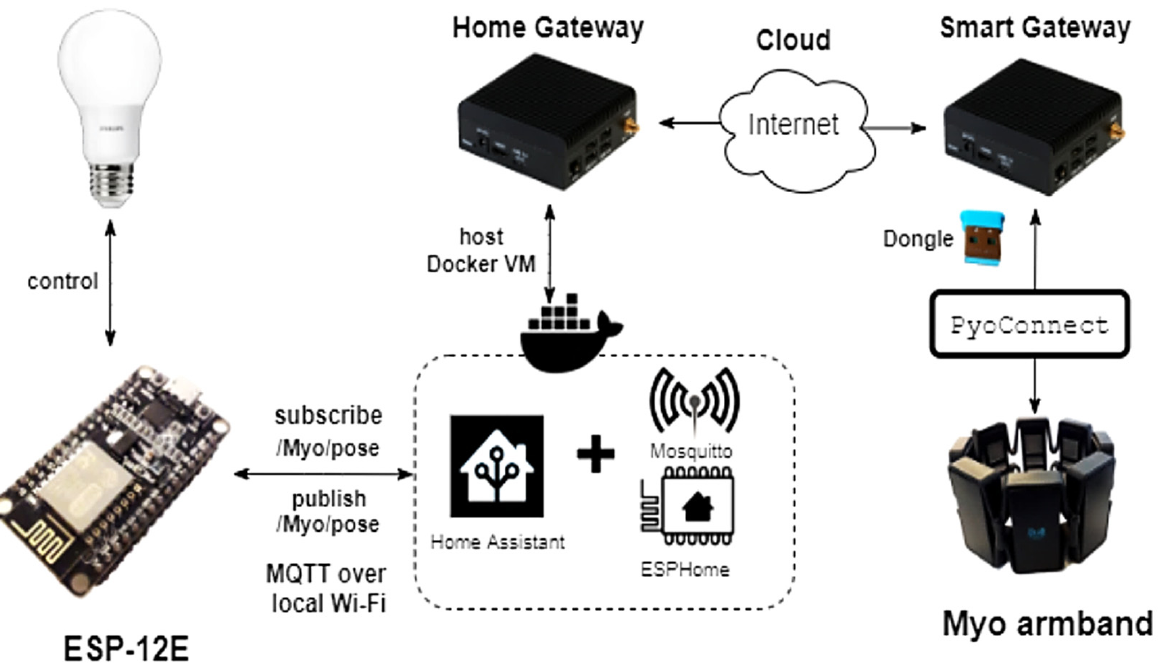
Figure 6. Architecture of the EMG-based control system proposed in [113] (Reproduced with permission from [113], IEEE, 2021).